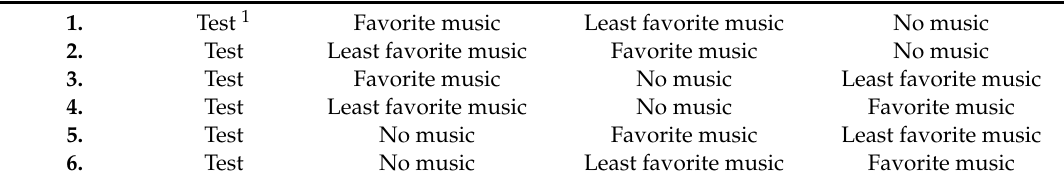
Table 1. Order of grip strength measurement